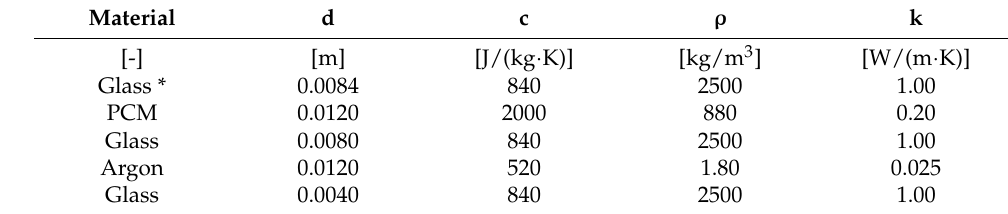
Figure 3. ( a ) scheme perspective view ( b ) Cross section of experimental set-up,: 1-distance element, 2-glass, 3-distance frame, 4-PCM, 5-argon section, 6-polystyrene, 7-construction element, 8-glazing unit, 9-coil, 10-fan. Table 3. Material parameters and dimensions.